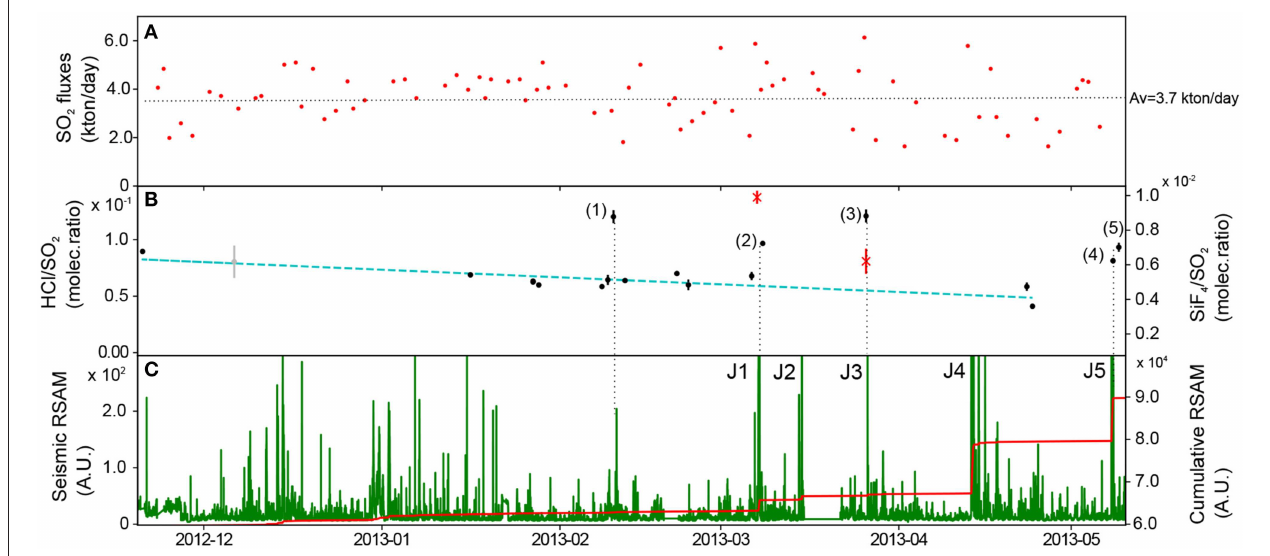
FIGURE 4 | Zoom of the (A) SO 2 fluxes, (B) HCl/SO 2 (in black and gray), and SiF 4 /SO 2 (in red) ratios and (C) seismic RSAM time series shown in Figure 2 from December 2012 to May 2013. In (B) the (1–5) points are outliers from the HCl/SO 2 declining trend (cyan) and correspond to ash venting episodes. In (C) J1–J5 denote main cumulative RSAM